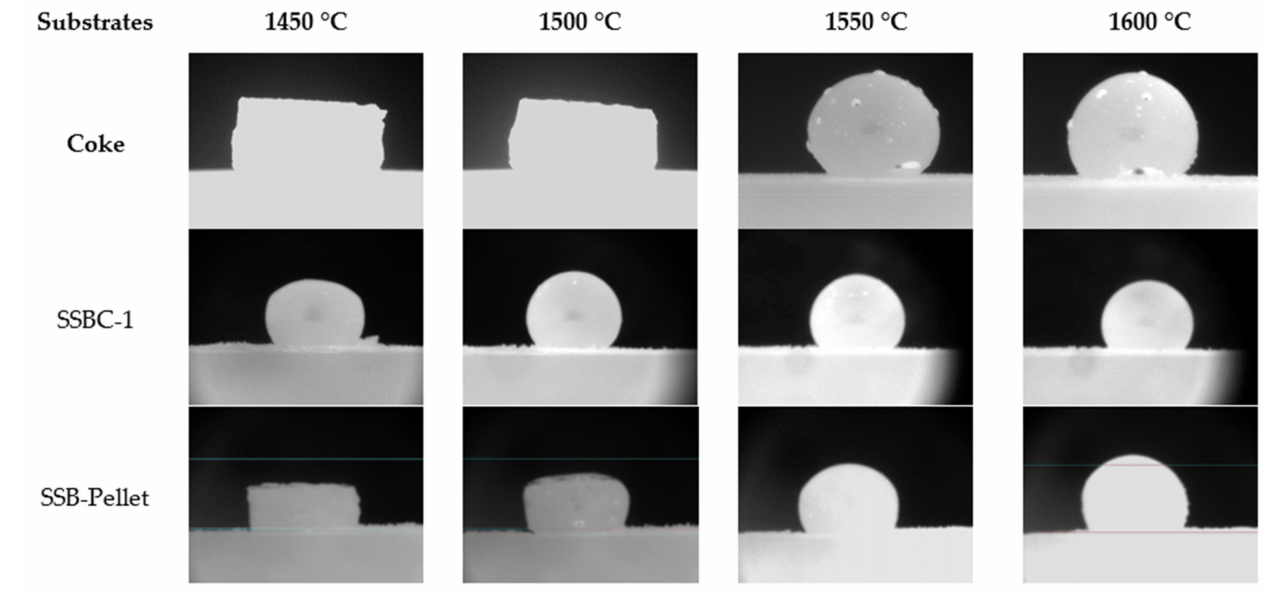
Figure 9. Slag droplets on loose (SSBC-1) and densified (SSB-Pellet) bio-char substrates.